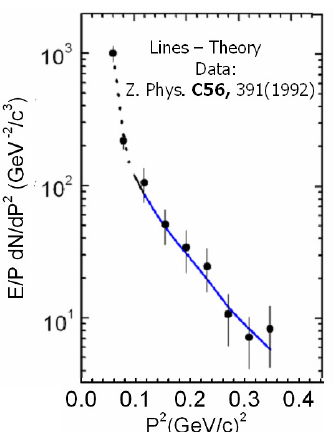
Figure 1. Invariant momentum distributions for backward emitted protons in interactions of neutrinos with nuclei in nuclear